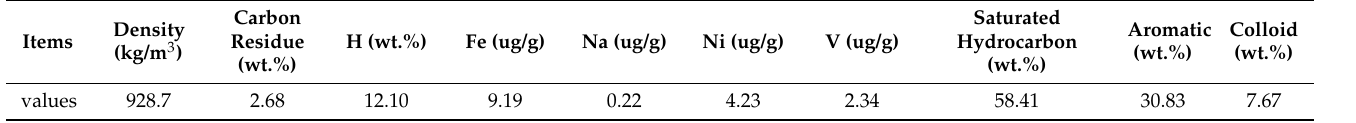
Table 6. Properties of raw